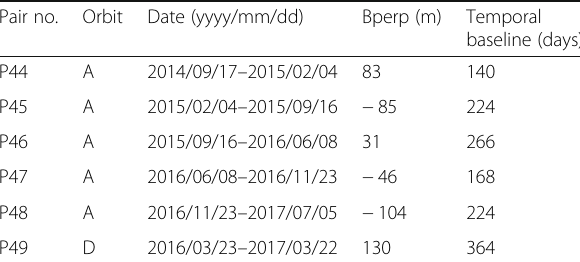
Table 4 ALOS-2/PALSAR-2 data sets for MAI images in Fig. 7. Details of the orbit, incidence, and heading angle are the same as in Table 2 Pair no. Orbit Date (yyyy/mm/dd)